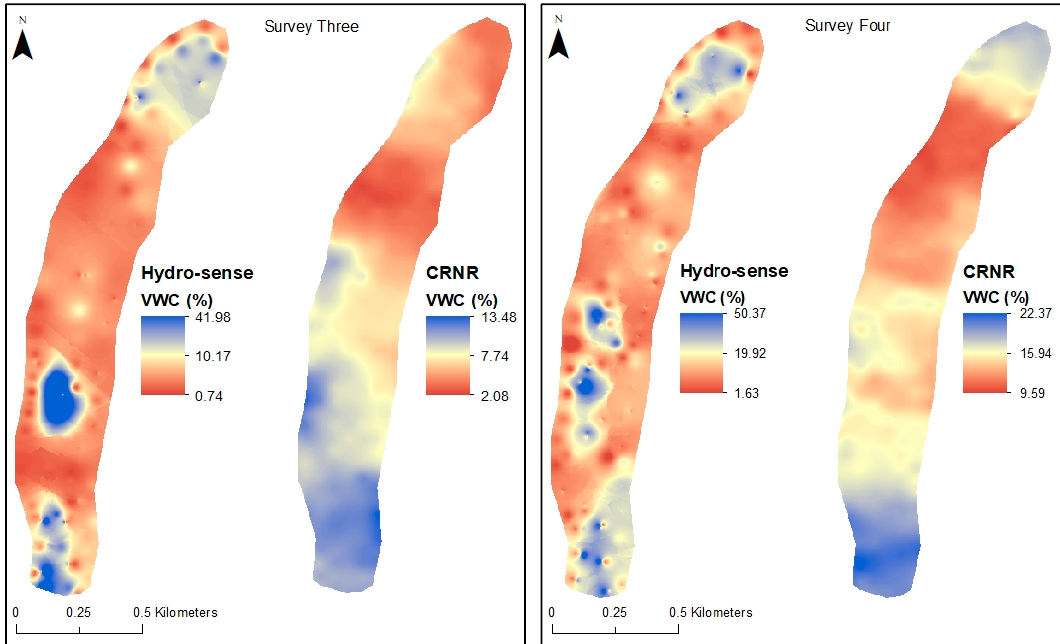
Figure 7. Hygrophilous grassland hydro-sense and CRNR soil water maps.